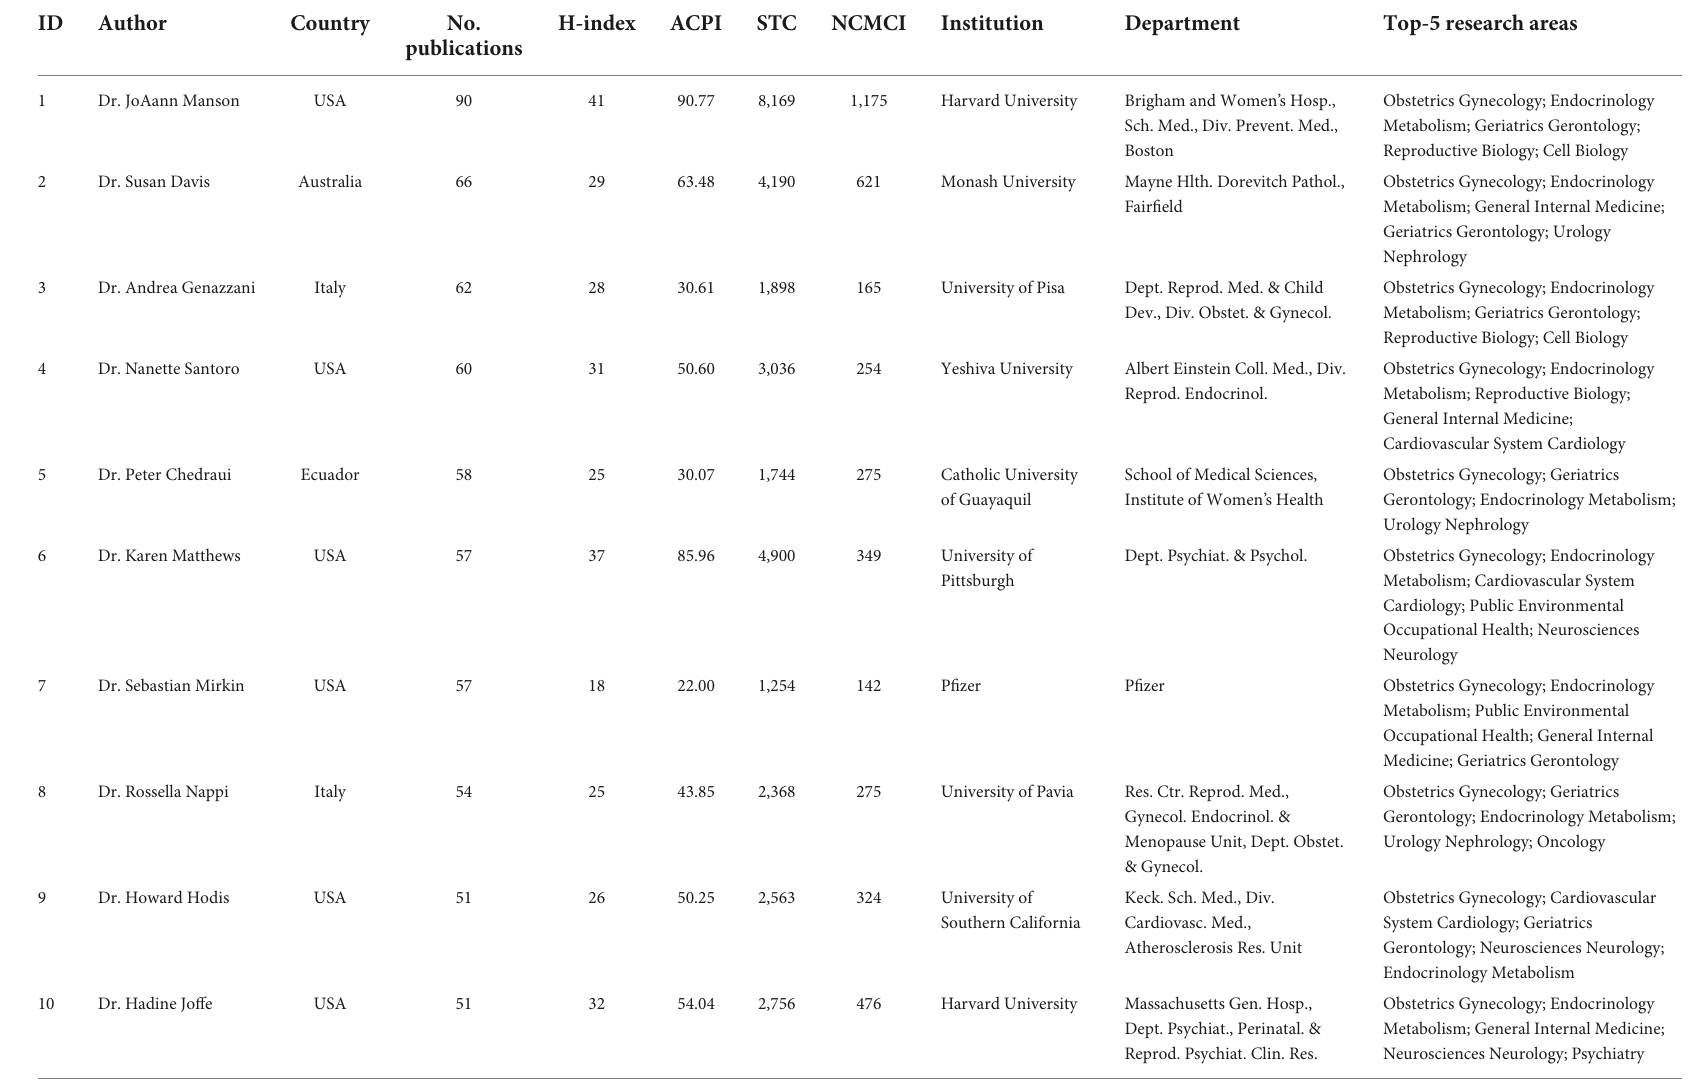
TABLE 4 Characteristics of the top-10 authors ( N =